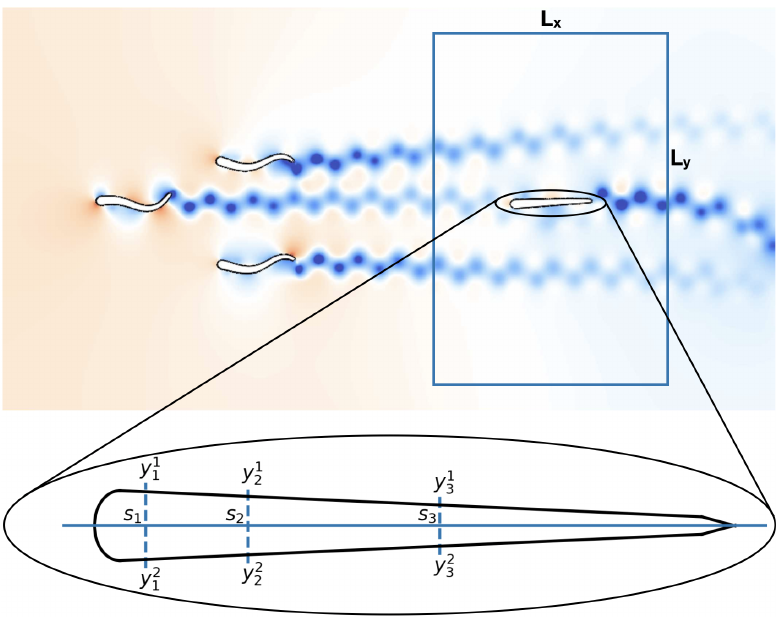
Figure 2. Simulation setup used for determining the optimal sensor distribution on a fish-like body. The follower is initially located inside the rectangular area. The number of swimmers in the leading group is varied between one and eight. The sensor-placement algorithm attempts to find the arrangement of sensors s that allows the follower to determine with lowest uncertainty the relative position r and the number of swimmers n f in the leading group of swimmers. For each sensor s k the swimmer collects measurements y 1 and y 2 at locations x 1 ( s k ) and x 2 ( s k ) on the skin, k k